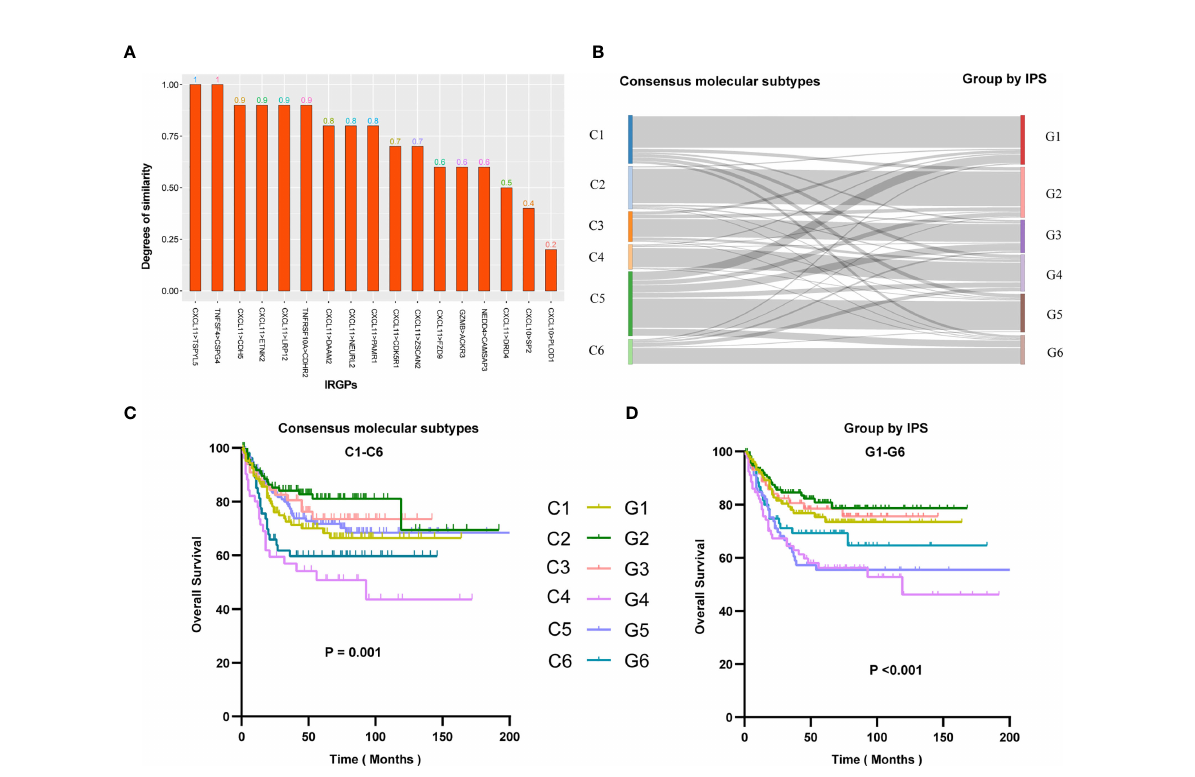
FIGURE 3 (A) Similarity of IPS results in array-based and sequence-based data. Similarity represents the proportion of samples with consistent IPS results in array-based and sequence-based data. The abscissa is the name of the gene pair, and the ordinate is the similarity of the gene pair in the two sets of data. (B) Re-strati fi cation of patients from six consensus molecular subtypes to the novel six immune score-based group of IPS. Each line represents a patient. Each line represents a sample. Kaplan – Meier analysis for patients in GSE39582 strati fi ed by consensus molecular subtypes (C) or IPS risk strati fi cation system (D)